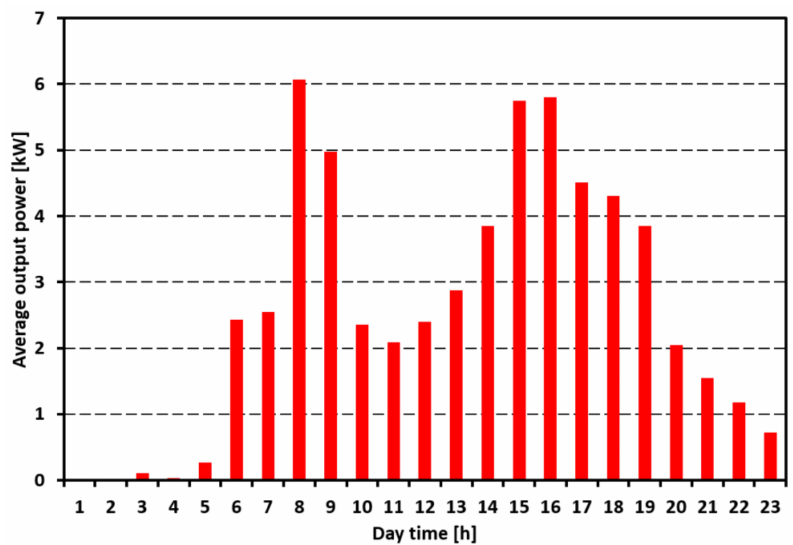
Figure 11. Average output load to traction network in hourly scale.